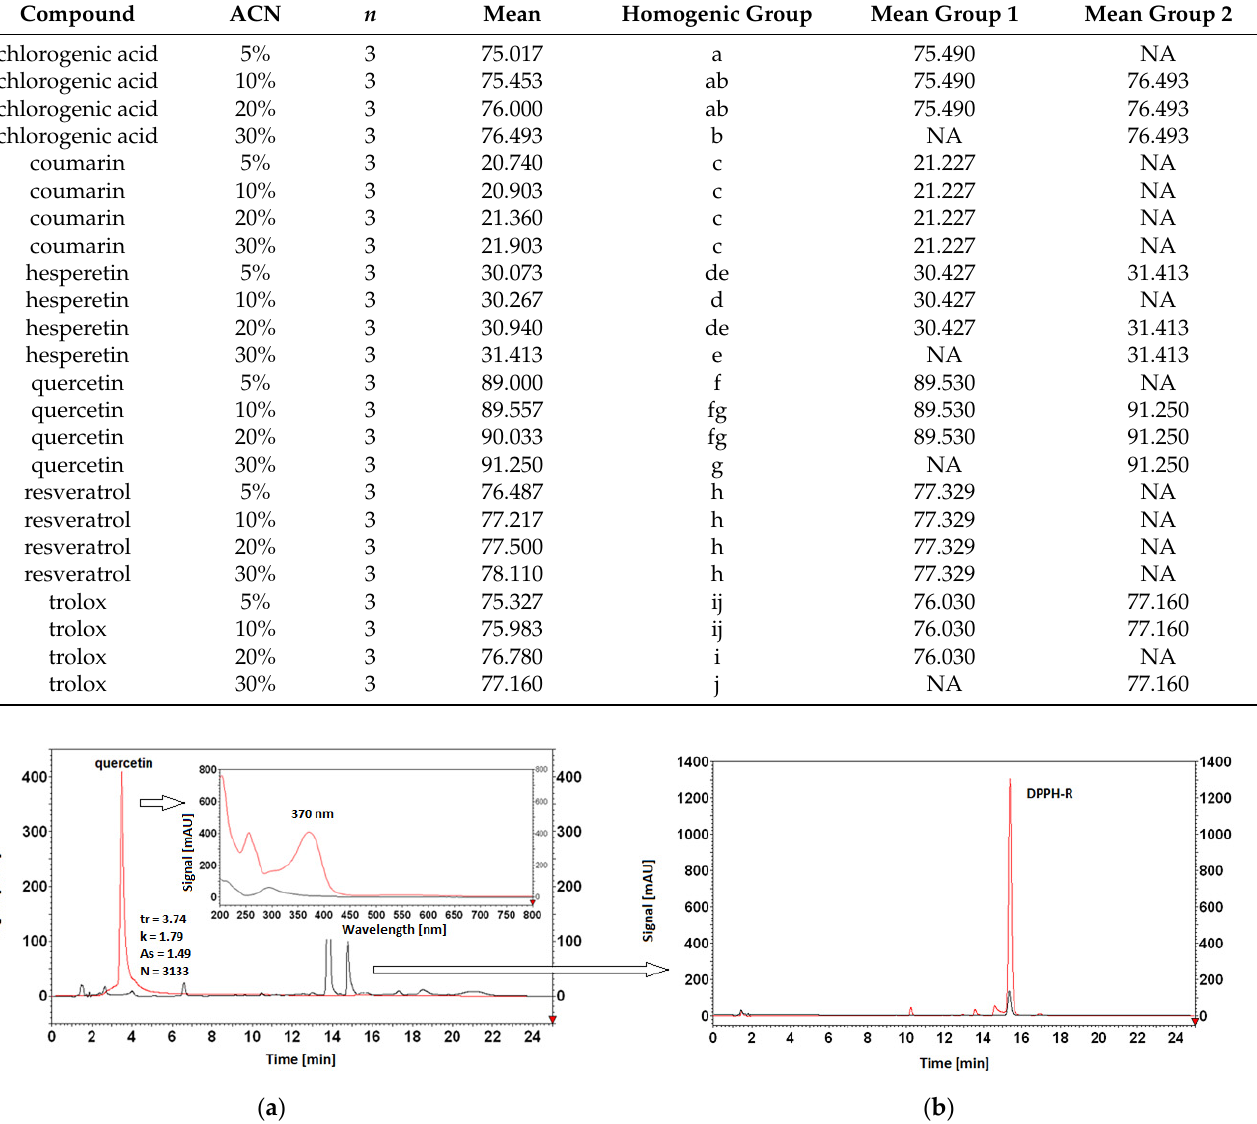
Table 4. Means of peak inhibition values obtained for the selected homogenic groups.